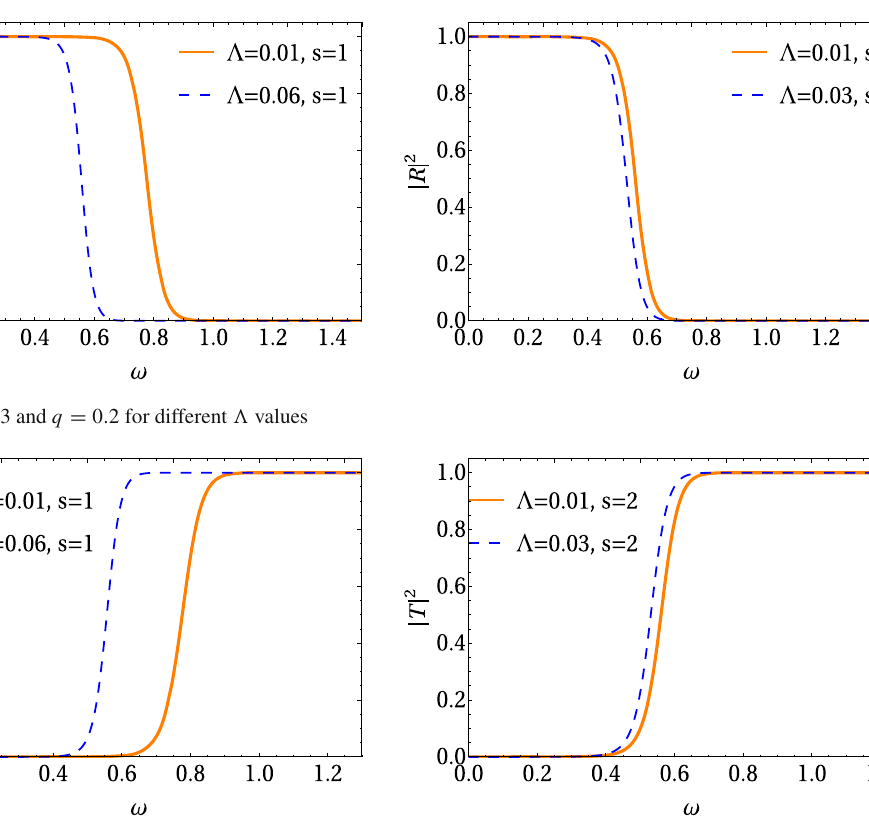
Fig. 20 | T | 2 vs ω for (cid:12) = 3 and q = 0 . 2 for different (cid:2)